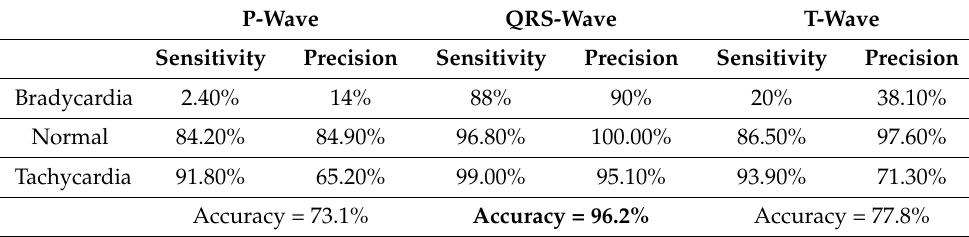
Table 5. Results of Scalogram and